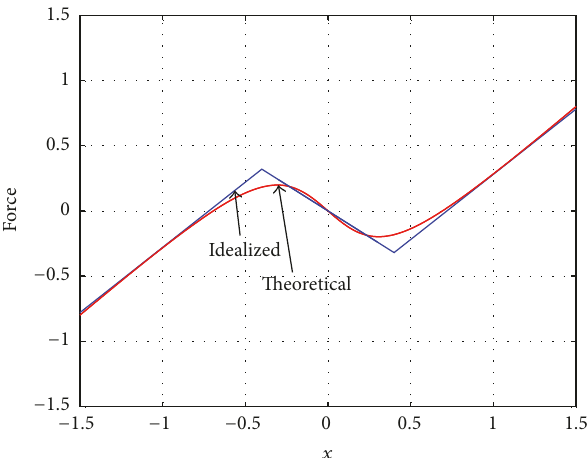
Figure 2: Comparison of the theoretical force and idealized force for 𝐾 = 0.5 , Δ = 1.1 , 𝐿 = 0.7 , 𝐾 1 = −0.65 , 𝐾 2 = 0.3 , and 𝑑 = 0.55